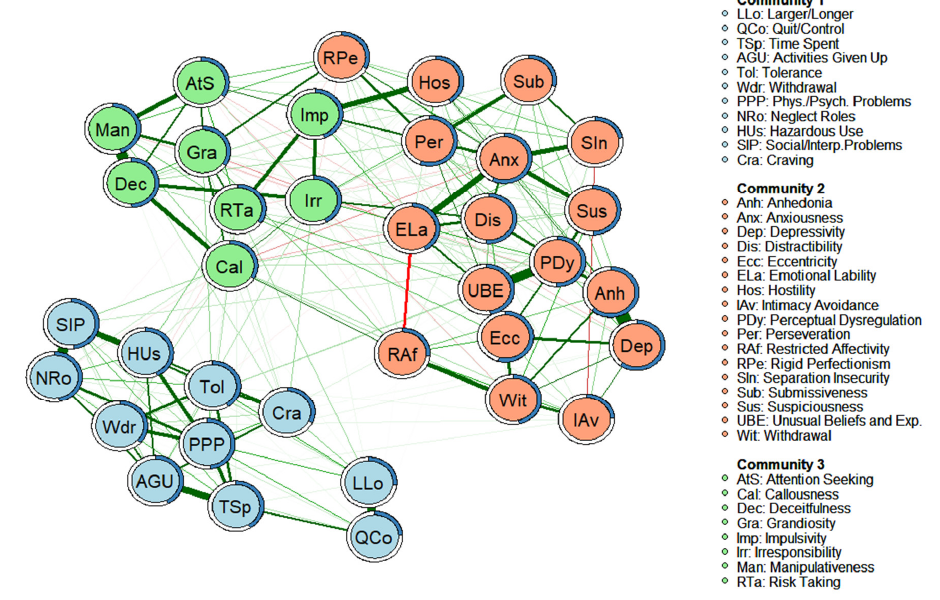
Figure 1. Empirical network model (network structure estimated from a walktrap modularity anal- ysis) for the complete sample ( n = 985). Note . Each node represents a symptom. The edges represent the relationships (partial correlations) between the symptoms. Positive relationships are repre- sented in green, and negative relationships in red. The thickness of the edge reflects the strength of the association, so that the most strongly related symptoms are connected by thicker edges. The blue pie chart surrounding each node represents the predictability of each node (a higher proportion of blue indicates greater predictability). The membership of the nodes to the different communities is represented by different colors: the symptoms of Community 1 are shown in blue, the symptoms of Community 2 are shown in salmon, and the symptoms of Community 3 are shown in green. The arrangement of the nodes was established based on the Fruchterman-Reingold algorithm. The standardized scores of the centrality indices, bridge-centrality indices, and the predictability of the nodes are displayed in Table 3. The nodes with the highest strength values were Anxiousness (1.94), Anhedonia (1.67), Perseveration (1.51), and Emotional lability (1.08). The highest EI1 values were for Perseveration (1.51), Anhedonia (1.48), Anx- iousness (1.43), and Physical/ Psychological Problems (1.23). The highest EI2 values cor-